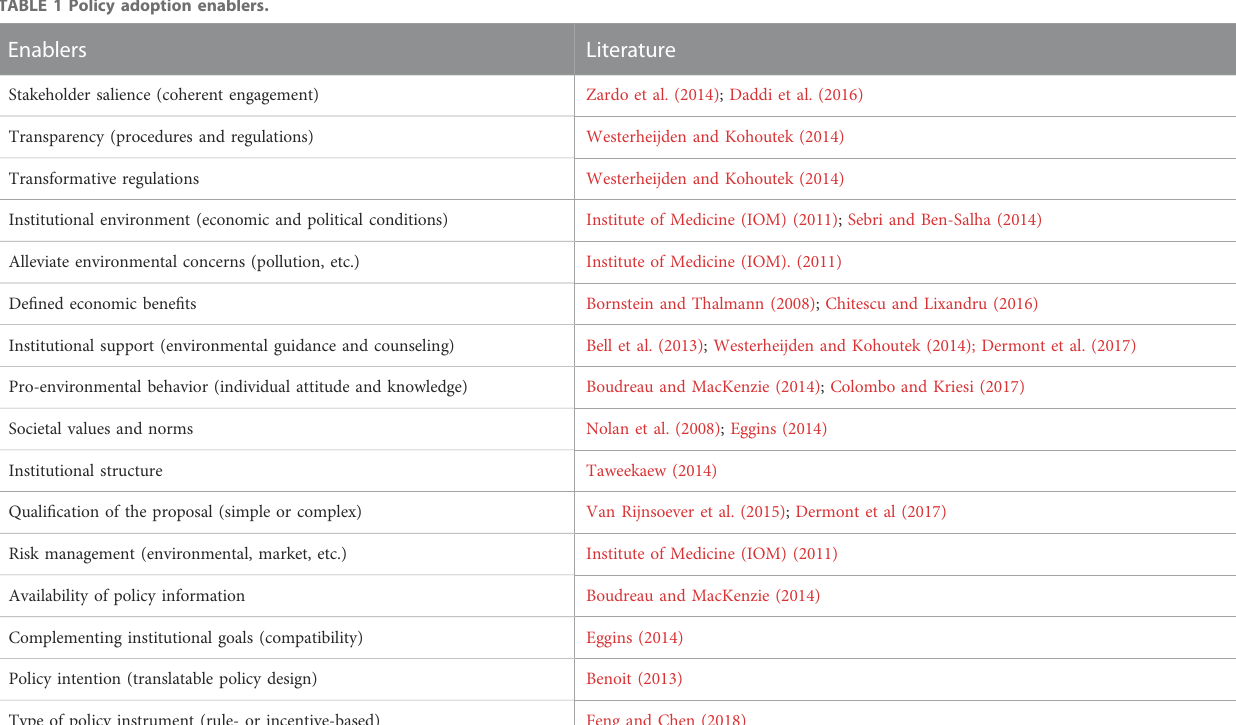
TABLE 1 Policy adoption